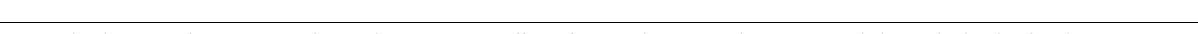
Fig. 3 Tax binding near the entry site of RNA decreases UPF1 af fi nity for its substrate. a The upper panel shows the levels of endogenous UPF1 immunoprecipitation (IP) from mock (lane 1), Tax (lane 2), pCMV- HTLV-1 Δ pX (lane 3) and pCMV- HTLV-1 WT (lane 4)-transfected HeLa cells. The lower panel represents the relative quanti fi cation of Gl-PTC RNA recovery upon UPF1 RIP. The ΔΔ Ct method of mRNA quanti fi cation was applied to each experimental condition. The control sample (Ctrl) derived from IP using immunoglobulin G (IgG) antibody. The values represented in each graph correspond to the mean of at least three biological replicates, and the error bars correspond to the SD. *** P < 0.005 with Student ’ s t- test (two-tailed, unpaired). b Representative native 8% polyacrylamide gel illustrating the interaction of UPF1-HD protein with a 30mer-ssRNA (grey line) labelled with 32 P (black star) with or without Tax CACA factor. The RNA substrate (1 nM) was incubated with increasing concentrations of UPF1-HD (0, 1, 3, 5 and 10 nM) alone or with 300 nM of Tax CACA . The absence of an interaction between Tax CACA and the substrate was also veri fi ed (lane 6). c Recapitulative tables of Bio-Layer Interferometry experiments listing K D , k on and k off in real-time measurements of UPF1-HD and UPF1-HD/Tax complex binding to 5 ′ biotinylated 30mer-ssDNA. These data were obtained using the BLItz ® System instrument and BLItz ® Pro 1.2 software (ForteBio). d Crystal structure of human UPF1- HD complexed with RNA substrate showing the position of the R843 residue 21 . The magni fi cation shows the structural model of the R843C mutant produced using I-Tasser software. e Protein co-precipitation with 3 ′ end-biotinylated 30-mer ssRNA (Bt-RNA). Combinations of UPF1-HD (lanes 1 and 2), UPF1-HD DE633AA (lanes 3 and 4) or UPF1-HD R843C (lanes 5 and 6) were mixed with Tax CACA (lanes 2, 4 and 6) and incubated in a buffer containing 200 mM NaCl before co-precipitation. Tax CACA was incubated with Bt-RNA alone as a control for aspeci fi c binding (lane 7). Input (20% of total) and pull-down fractions were analysed by 12% SDS-PAGE followed by coomassie blue staining. f Recapitulative tables of BLItz listing K D , k on and k off in real-time measurements for UPF1-HD WT , UPF1-HD DE633AA , UPF1-HD R843C and UPF1-HD R843S binding to Tax. Uncropped scans related to Fig. 3 are available